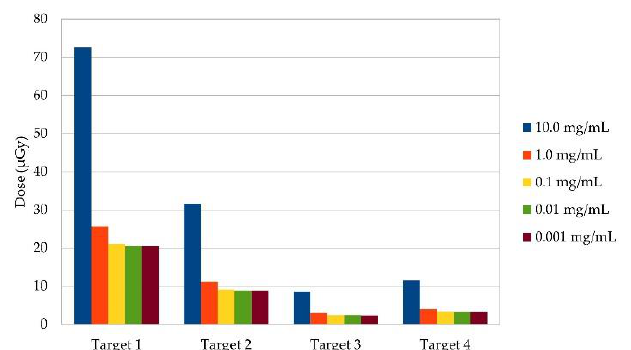
Figure 6. Dose deposition per shot in lung targets depending on gold concentration and target size. Targets are groups of gold-filled voxels in right lung, and their size increases with their number. Dose is higher for higher gold concentrations, due to more absorption because of density of lung targets. With bigger size of target, dose is lower because it also depends on the mass of lung targets. However, for target 4, doses are higher than for target 3, as increase in voxels in beam volume outweighs increase in total mass of target.